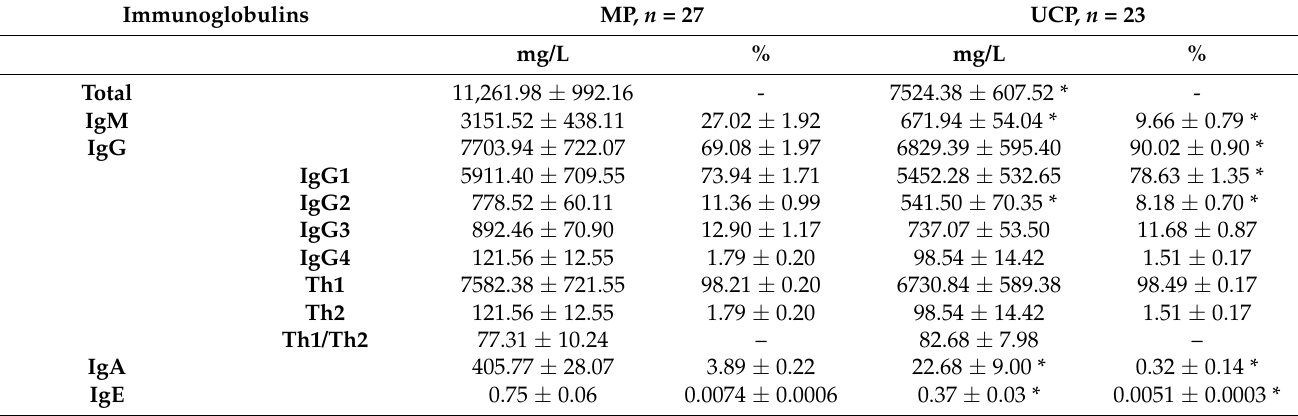
Table 3. Concentrations and relative frequencies of immunoglobulins in maternal and umbilical cord plasma.